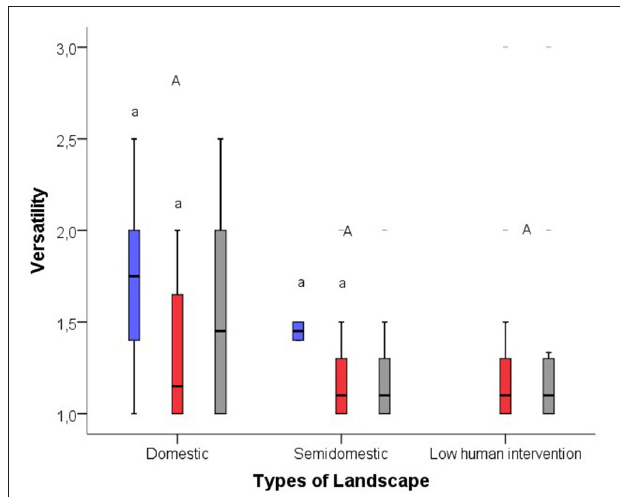
FIGURE 5 | Average use versatility (UV) of species according to biogeographic origin, and total value for the different landscape categories (domestic, semi-domestic and low human intervention): Key: (cid:4) UV of native plants; (cid:4) UV of exotic plants; (cid:4) Total UV. A: No significant differences to versatility between